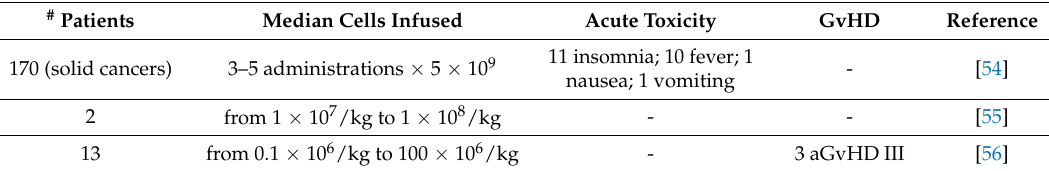
Table 2. Most relevant clinical studies with haploidentical CIK